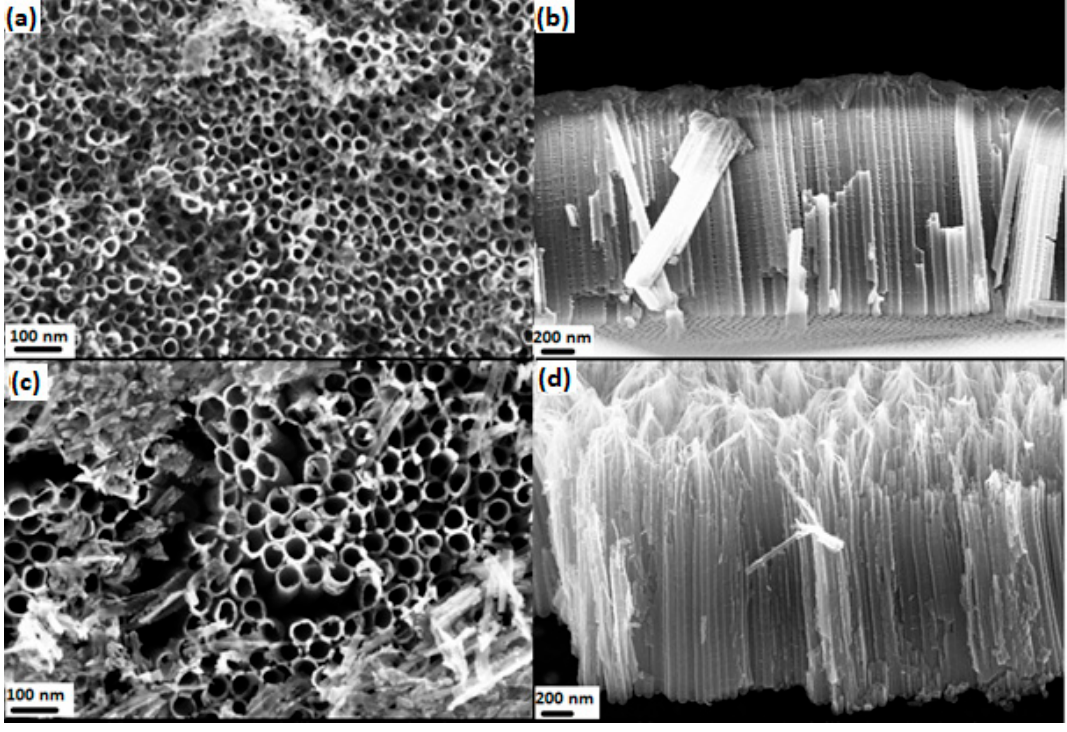
Figure 5. Surface and cross-section images of the TiO 2 nanotubes prepared using different ammonium fluoride concentrations ( a , b ) 0.4 wt% NH 4 F ( c , d ) 1.4 wt% NH 4 F (constant anodization time (30 min) and anodization voltage (30 V)).